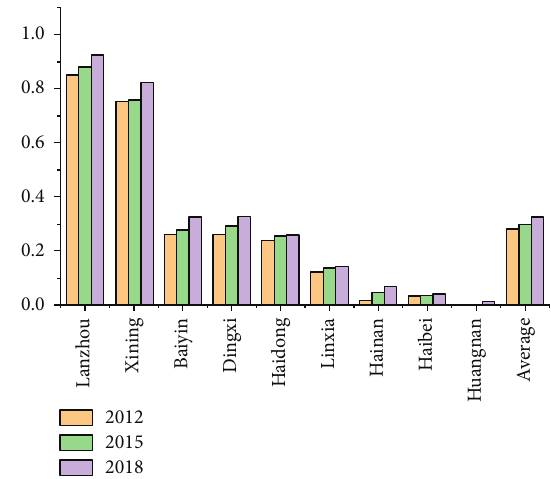
Figure 4: Urban connection index in Lanzhou-Xining urban